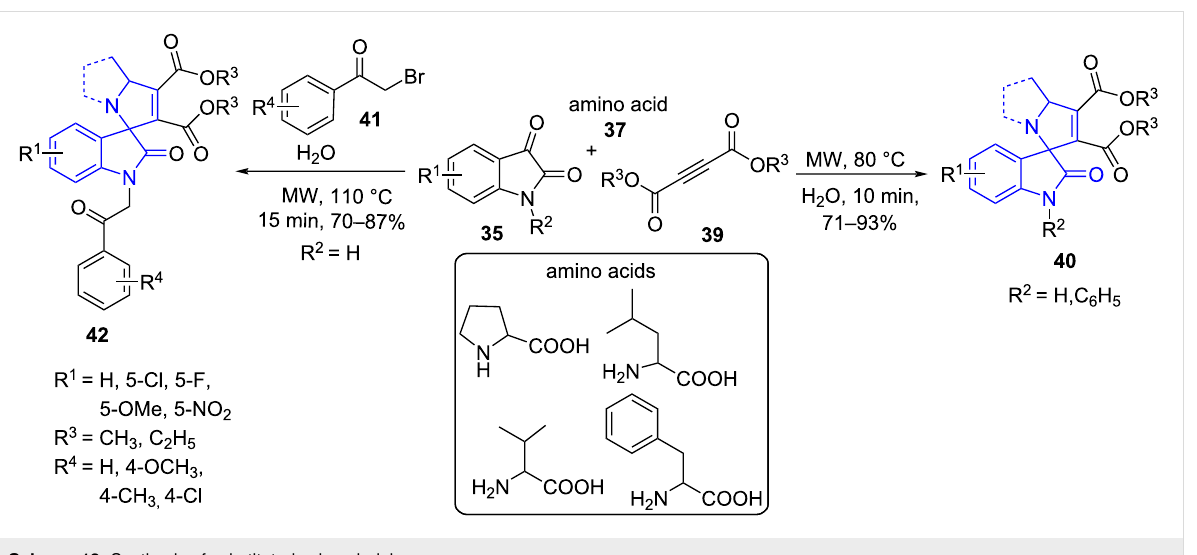
Scheme 13: Synthesis of substituted spirooxindoles.